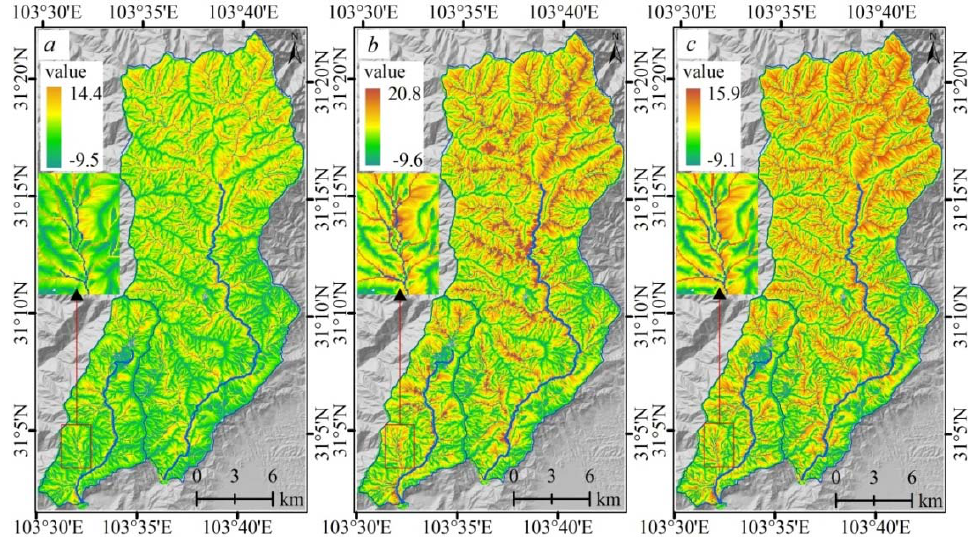
Figure 9. ( a ) Pre-earthquake SFCI map of the study area; ( b ) 2008–2009 SFCI map of the study area; ( c ) 2014 SFCI map of the study